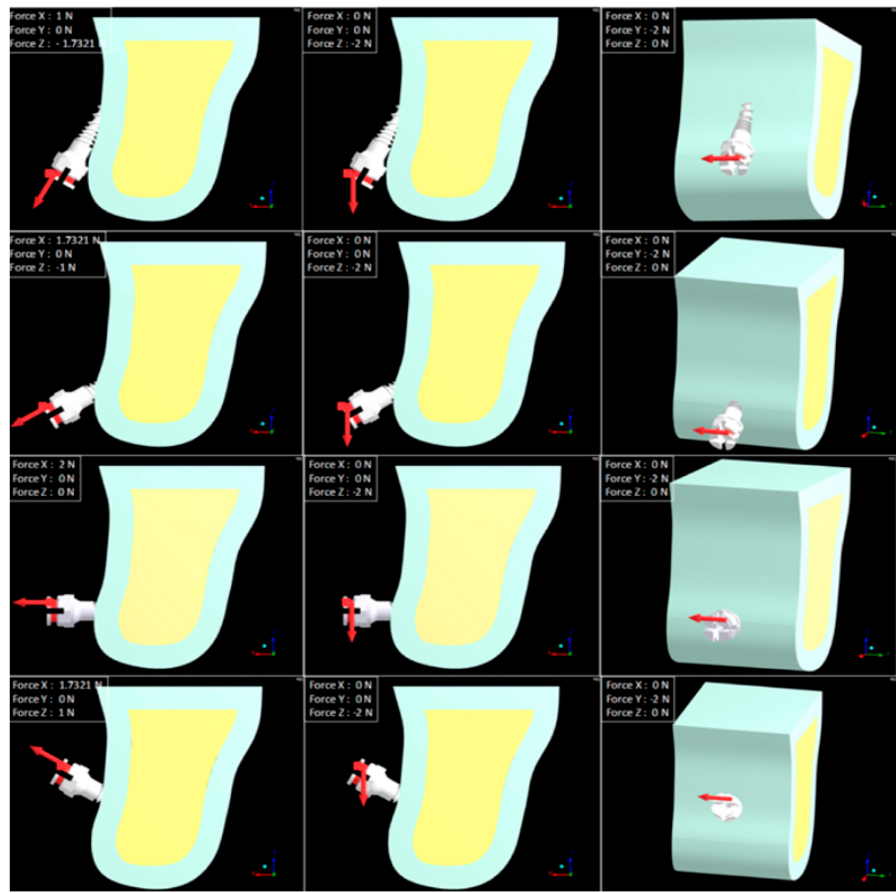
Figure 2. Insertion angles and force directions.